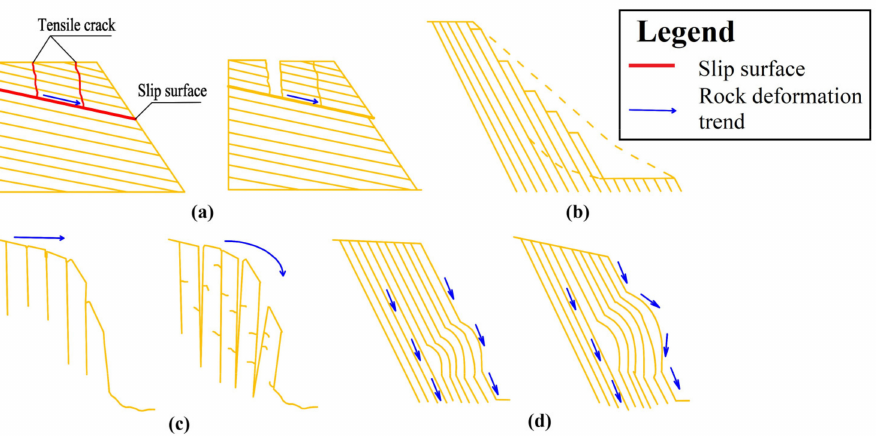
Figure 1. Typical failure mode of bedded rock slopes (Wang 2010): ( a ) sliding–tension failure, ( b ) sliding–shear failure, ( c ) bending–tension failure, ( d ) sliding–bending